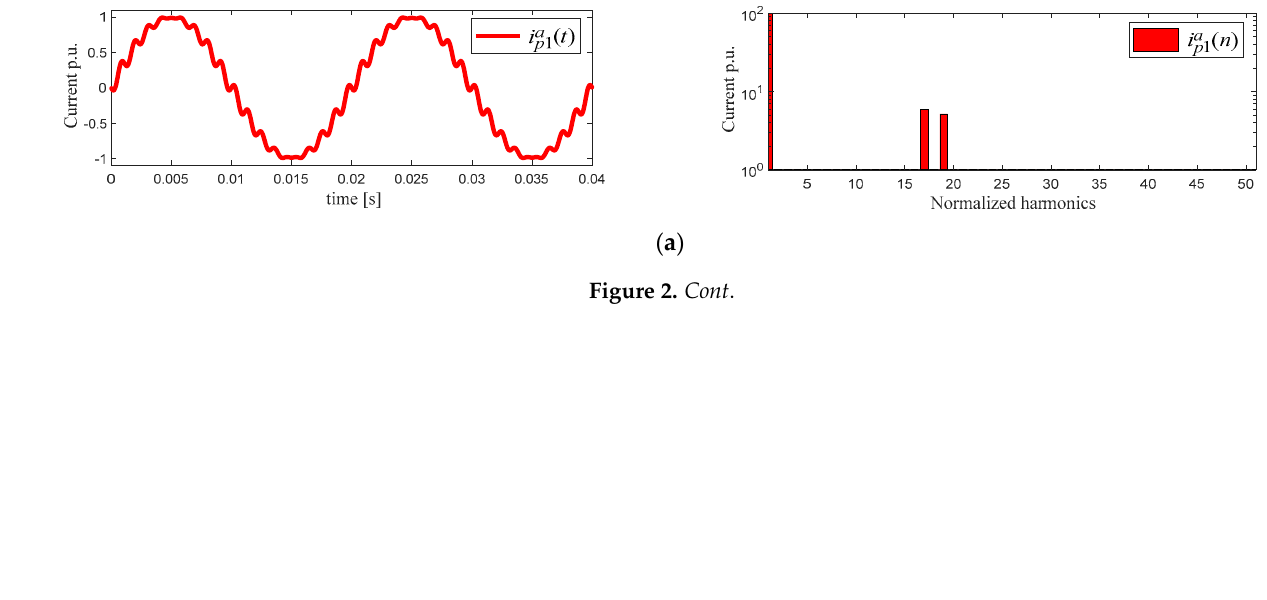
( c ) ( d ) Figure 2. Input current references and harmonic content AFE rectifier for phase a . ( a ) AFE rectifier 1, ( b ) AFE rectifier 2, ( c ) AFE rectifier 3, ( d ) multicell AFE rectifier input current.